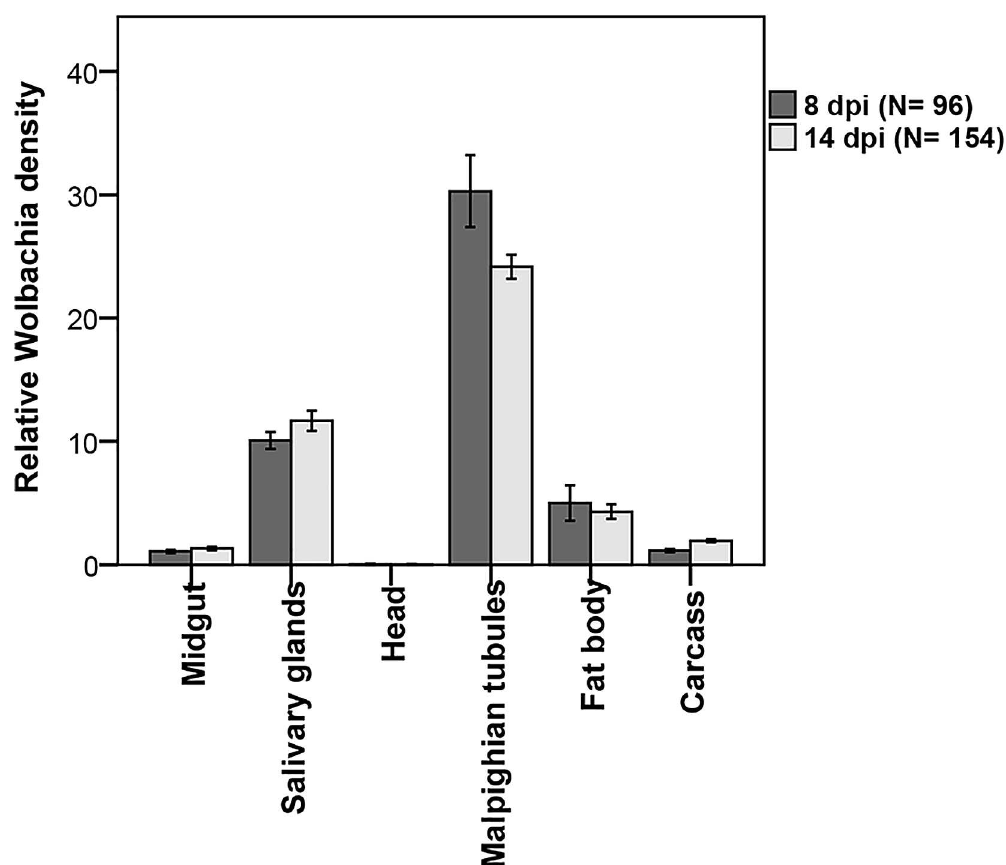
Fig 5. Wolbachia tissue densities in Ae aegypti . Malpighian tubules had the highest density and head the lowest